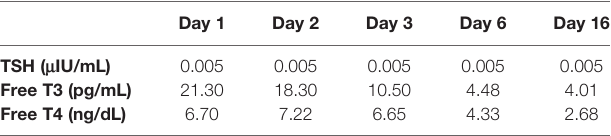
TABLE 1 | Progression of TSH, free T4, and free T3 during the clinical